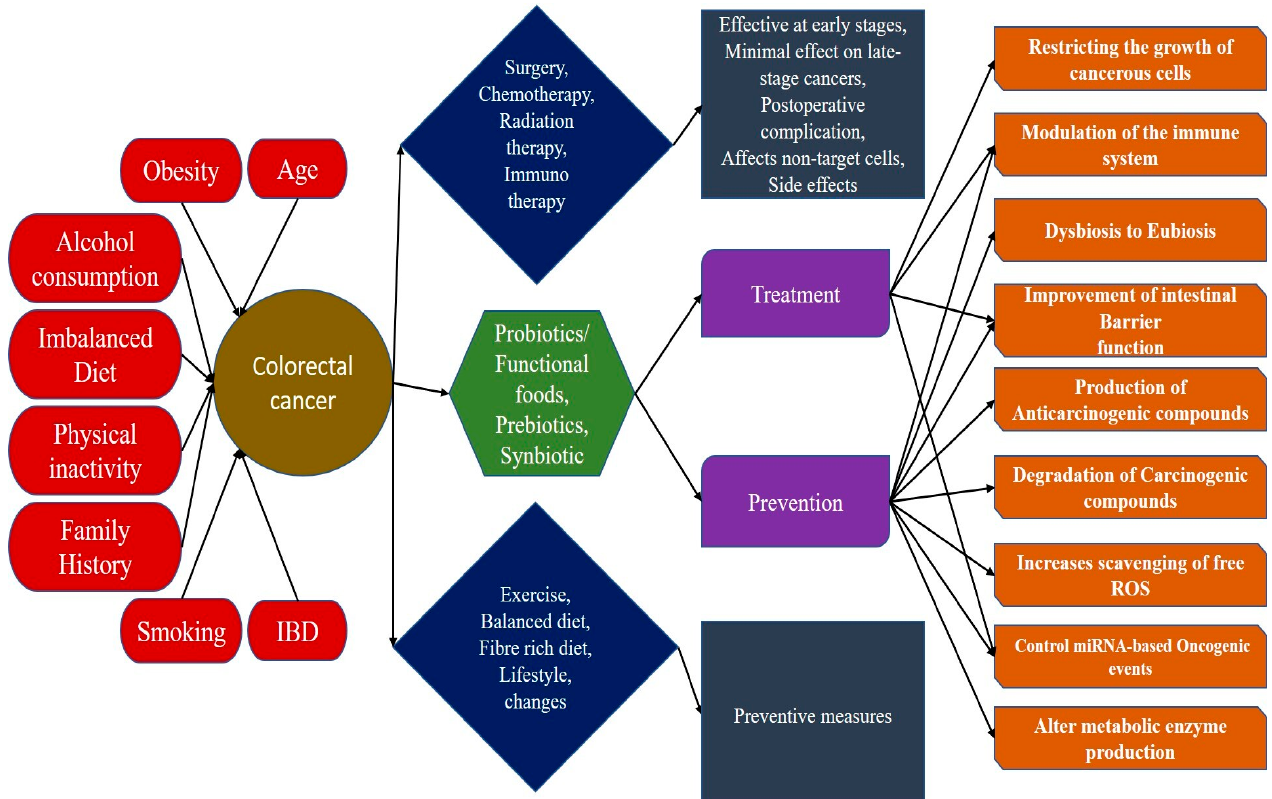
Figure 1. An illustration of the holistic picture of different causes and treatment strategies for colorectal cancer. Different environmental and lifestyle factors contribute to the development of colorectal cancer. Treatment strategies for colorectal cancer come with some additional drawbacks, such as its effectivity at only early stages, minimal effect on late-stage cancer, off-target effects and complications. A change in lifestyle decreases the chances of the occurrence of the disease. Probiotics/functional foods provide preventive measures through a range of different mechanisms and hold the ability for becoming a possible treatment strategy for colorectal cancer due to its anticancer and immunomodulatory properties.